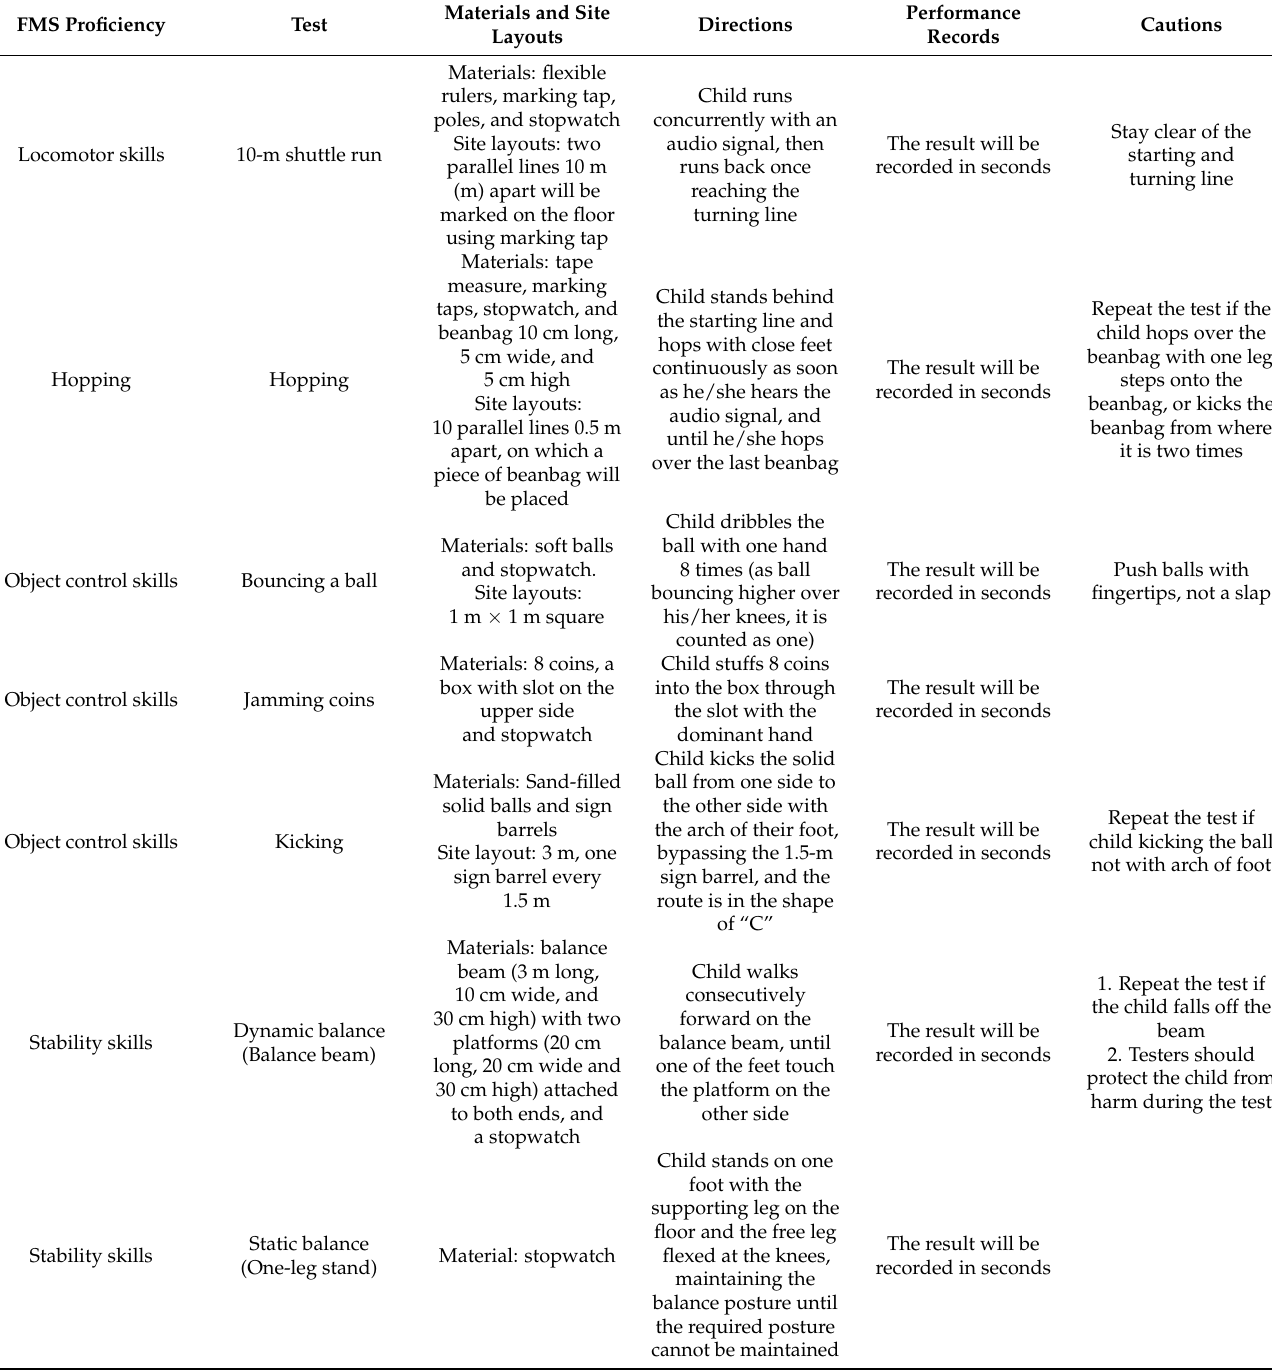
Table 2. The Fundamental Movement Skills